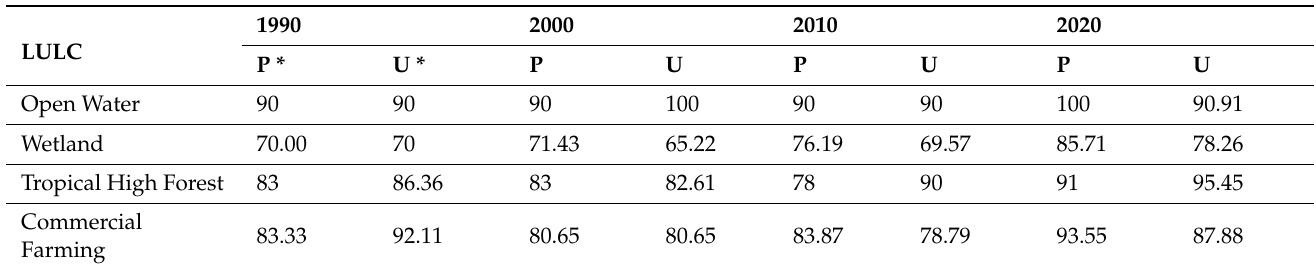
Table A3. LULC classification accuracy